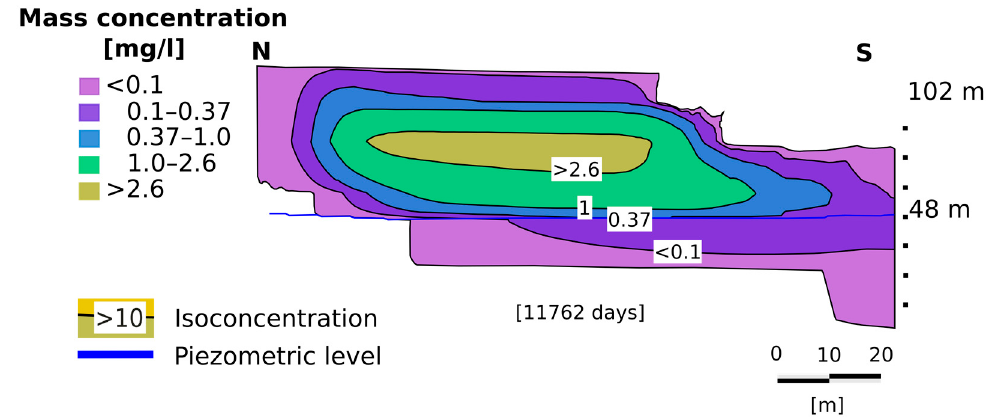
Figure 12. Concentration of 8 × 10 − 5 mg/L of dissolved benzene detected on the water table at 692 days.